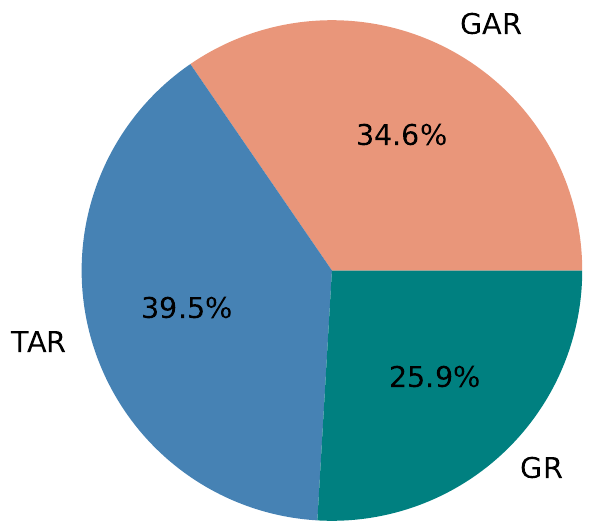
Figure 13. Quickest response for non-risky